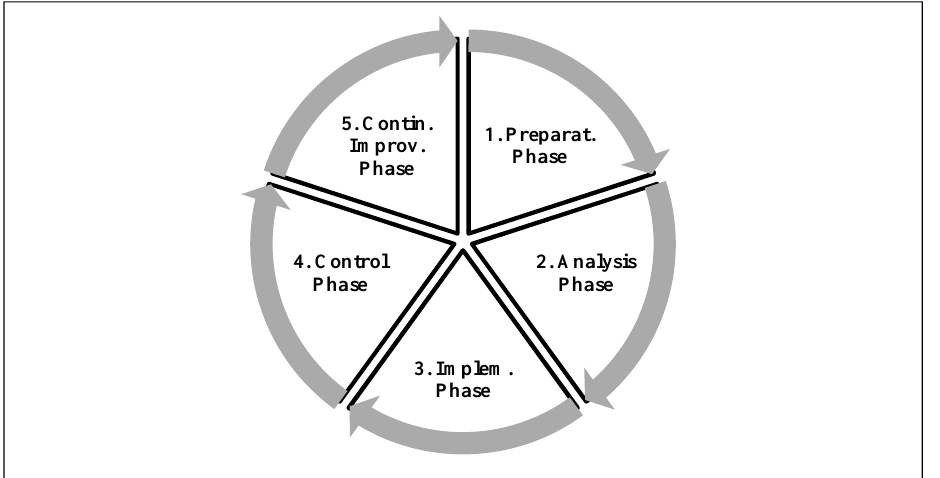
Figure 4 – The methodology of integrated TQM and BPR